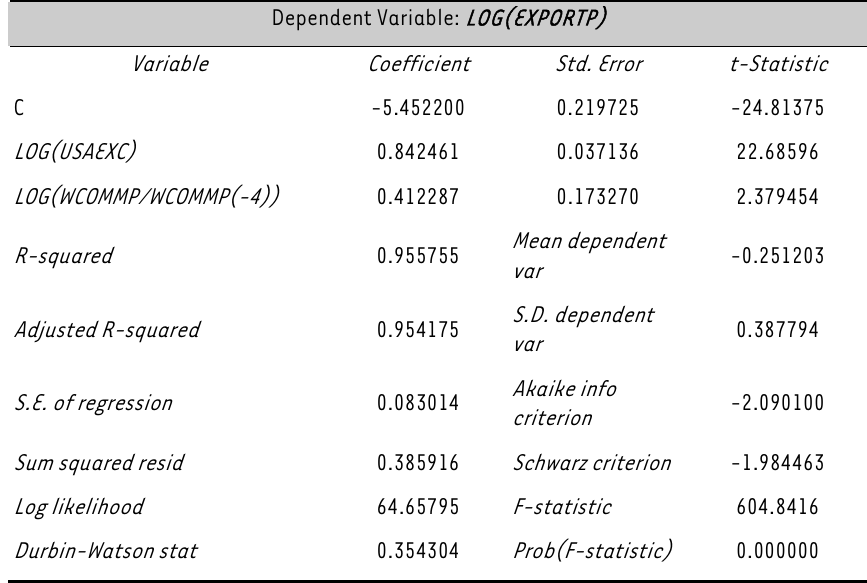
TABLE 2: Regression results for